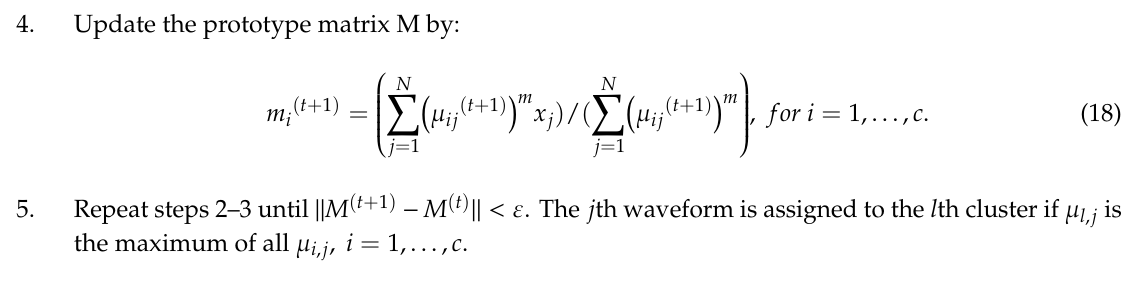
Figure 3. 2-D seismic data cross T615. The area between T74 Top and Bottom is the target reservoir. 4.2. Time–Frequency Features In this section, we compare the EMD and CEEMDAN methods using seismic signal (shown in Figure 4) to demonstrate the advantages of CEEMD.